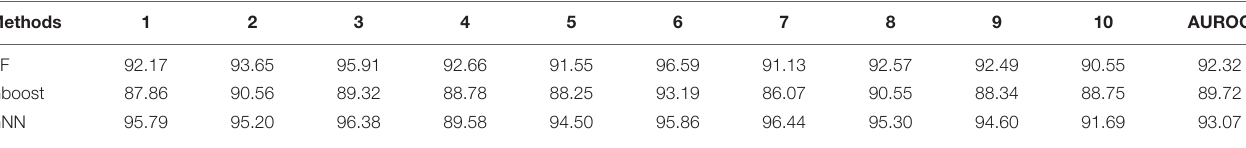
TABLE 9 | Ten-fold cross validation accuracies for link prediction using RF, Gboost, and GNN in GDKG.